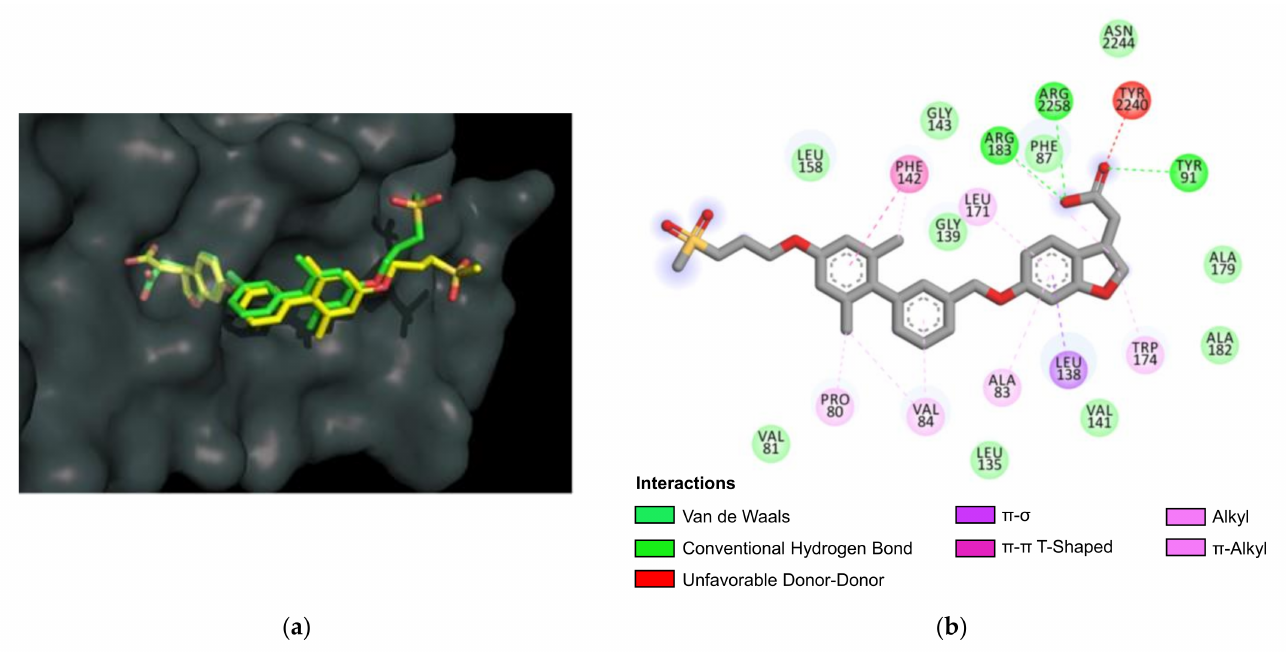
Figure 5. ( a ) Experimental (yellow) and docked (green) configurations of TAK-875 bound to FFA1. ( b ) 2D graphic of the interaction between TAK-875 and